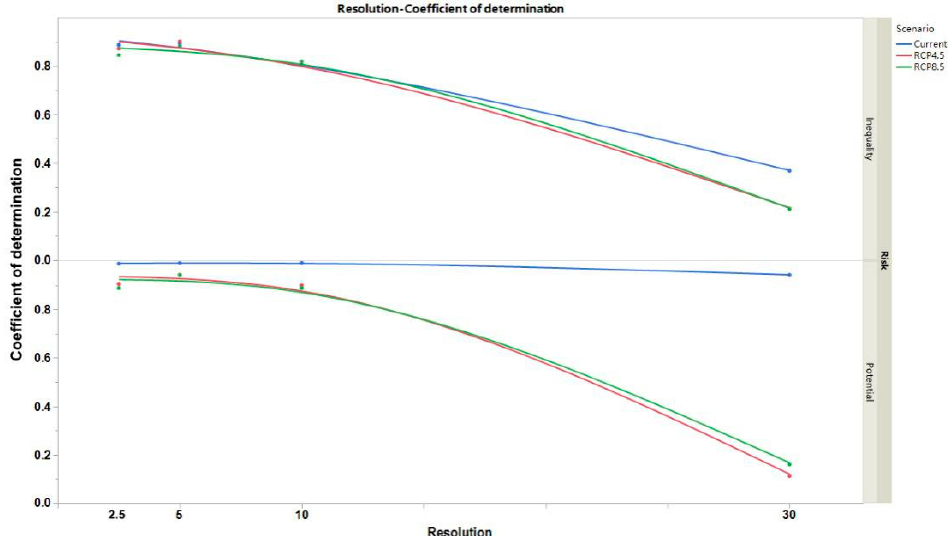
Figure 3. The linear relationship (coefficient of determination; R 2 ) of risk of IAPS for protected areas, comparing different scales of resolution (i.e., 0.5 arcminutes, 2.5 arcminutes, 5.0 arcminutes, and 10.0 arcminutes) and PC1 in different concentration scenarios. Current: the present day; RCP4.5: low-gas-concentration scenario; RCP8.5: high-gas-concentration scenario; 0.5: 0.5 arcminutes; 2.5: 2.5 arcminutes; 5.0: 5.0 arcminutes; 10.0: 10.0 arcminutes. All the relationships were significant (i.e., p < 0.001).